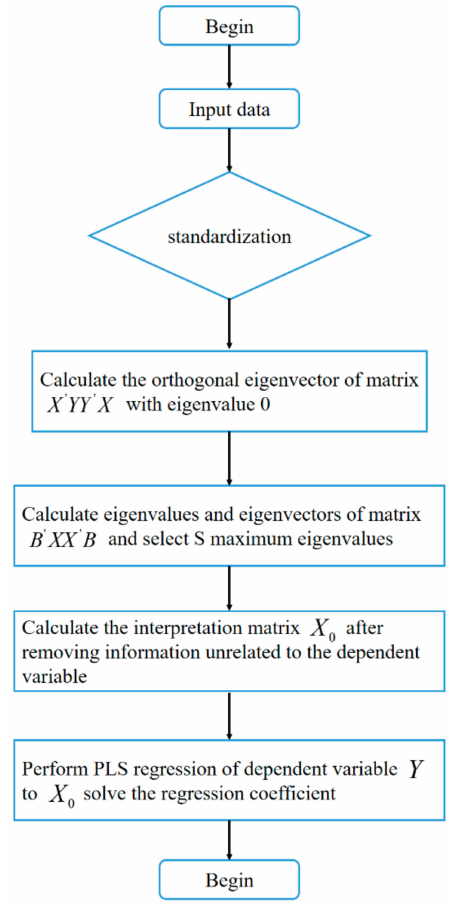
Figure 6. Schematic diagram of axis